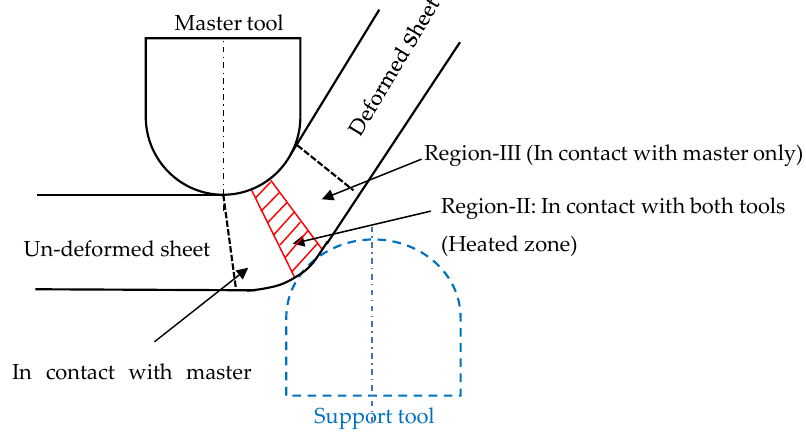
Figure 8. Deformation zones in the E-DSIF process. Zhang et al. [40] analyzed the strain evolution for clover flange (Figure 9).